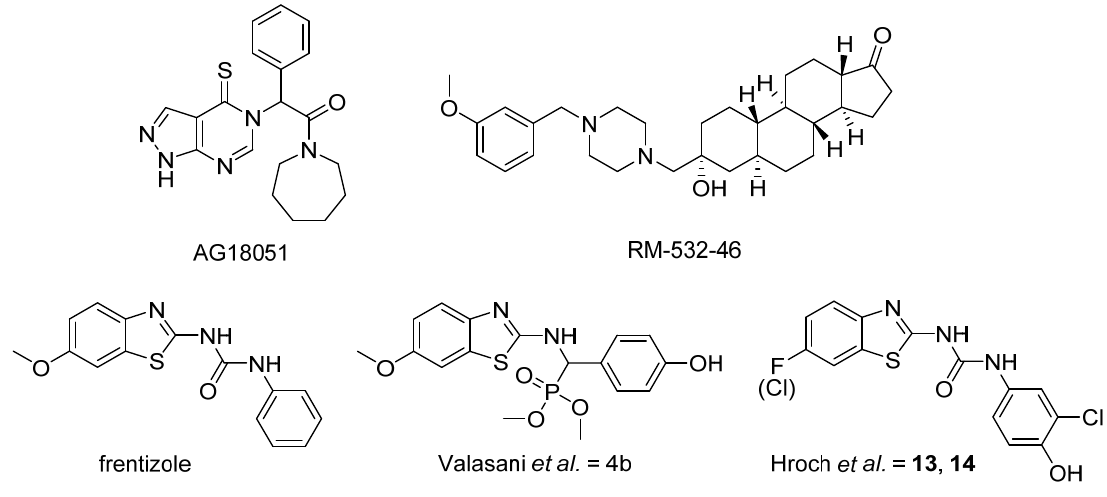
Figure 1. Structures of known 17 β -HSD10 inhibitors and frentizole.